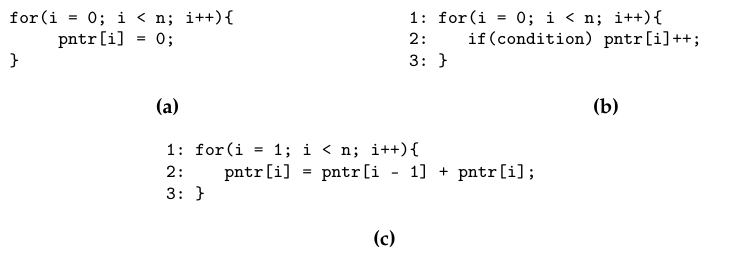
Figure 2. Subscript array pntr derives monotonic values in three steps: loop in ( a ) initializes pntr to zero; loop in ( b ) conditionally increments pntr ; ( c ) sum recurrence.